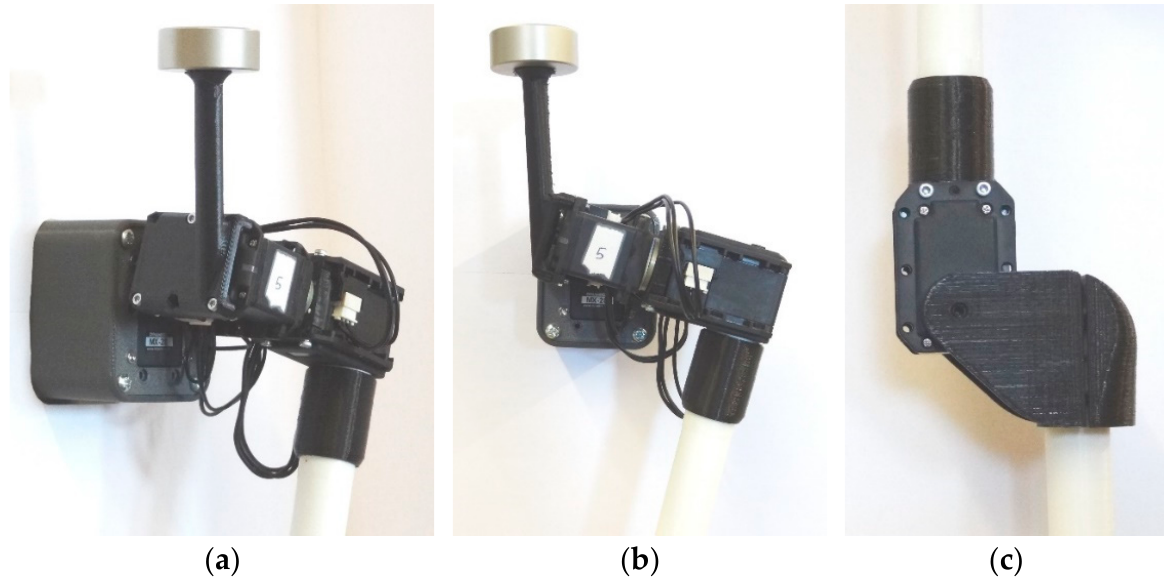
in the back- (cid:2869) . (cid:2872)